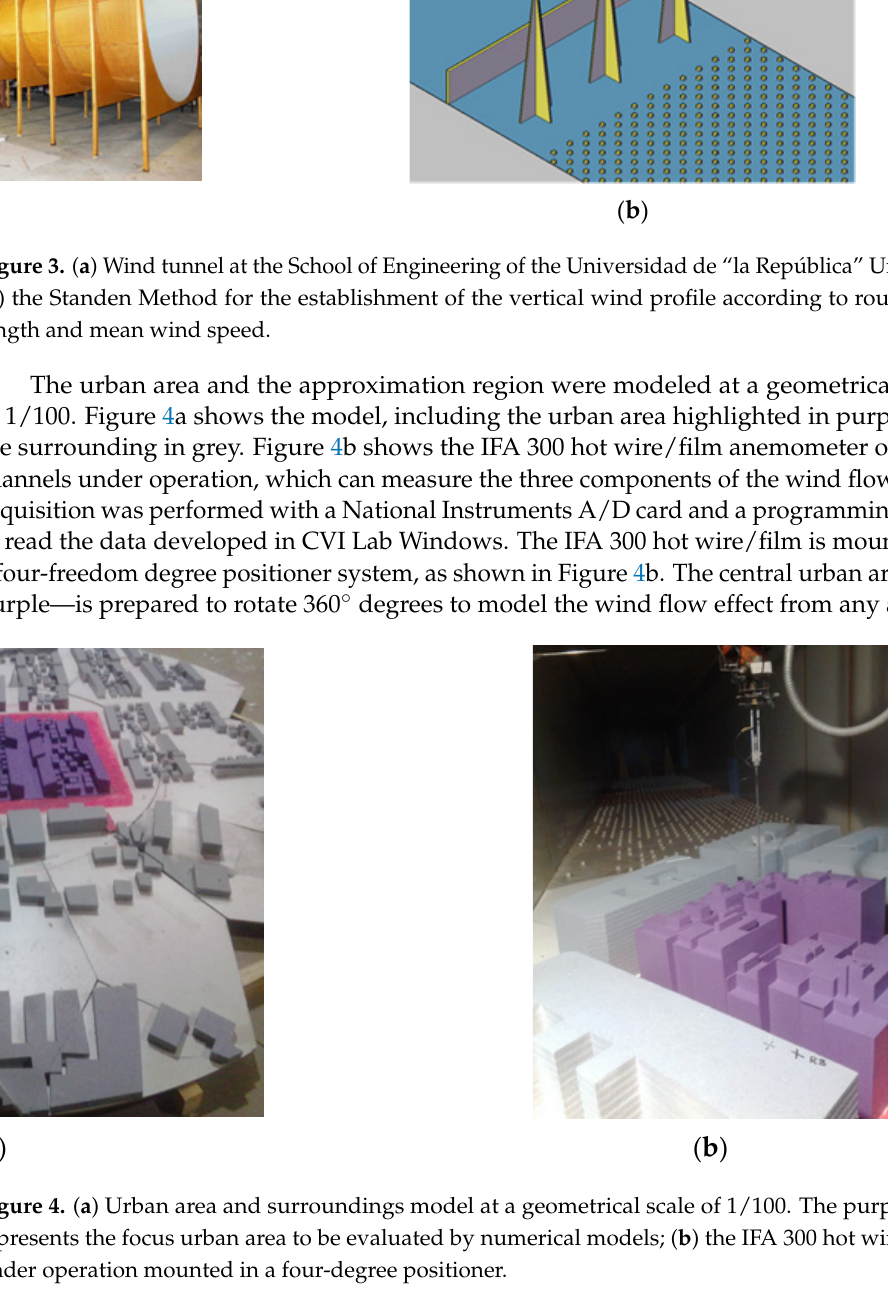
Figure 4. ( a ) Urban area and surroundings model at a geometrical scale of 1/100. The purple area represents the focus urban area to be evaluated by numerical models; ( b ) the IFA 300 hot wire/film under operation mounted in a four-degree positioner. 3.2. Windsim Model